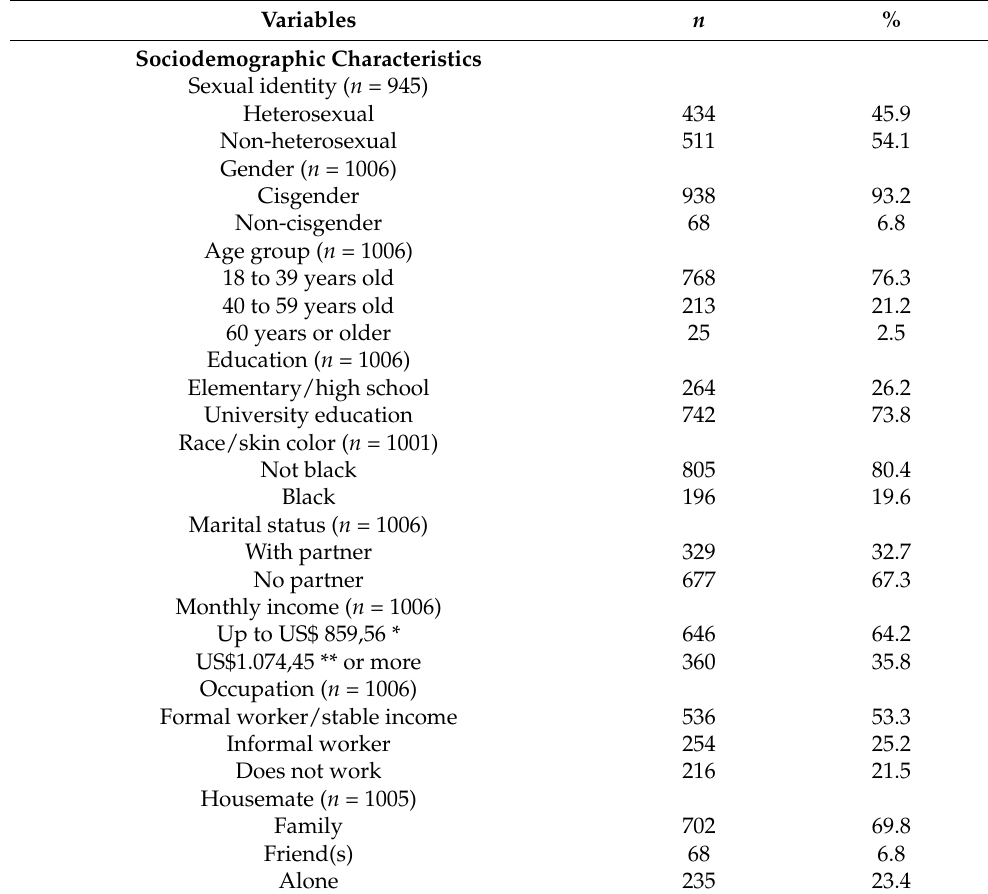
Table 1. Distribution of men according to sociodemographic characteristics and mental health status in Brazilian men. Brazil,